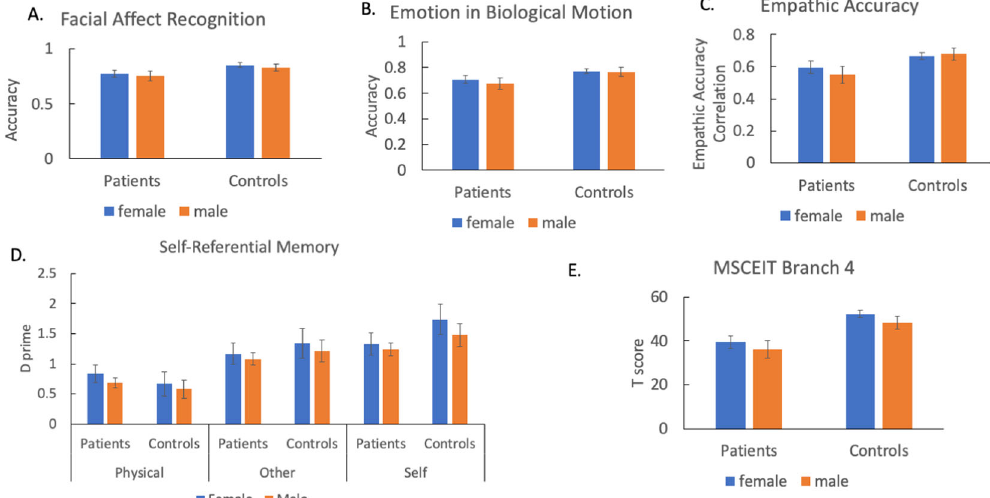
Fig. 1 Performance of patients and controls on objective social cognitive tasks. A Facial affect recognition, B Emotion in biological motion, C Empathic accuracy, D Self-referential memory, and E MSCEIT branch 4. Error bars indicate 95% con fi dence interval. MSCEIT the Mayer – Salovey – Caruso Emotional Intelligence Test 2.0.